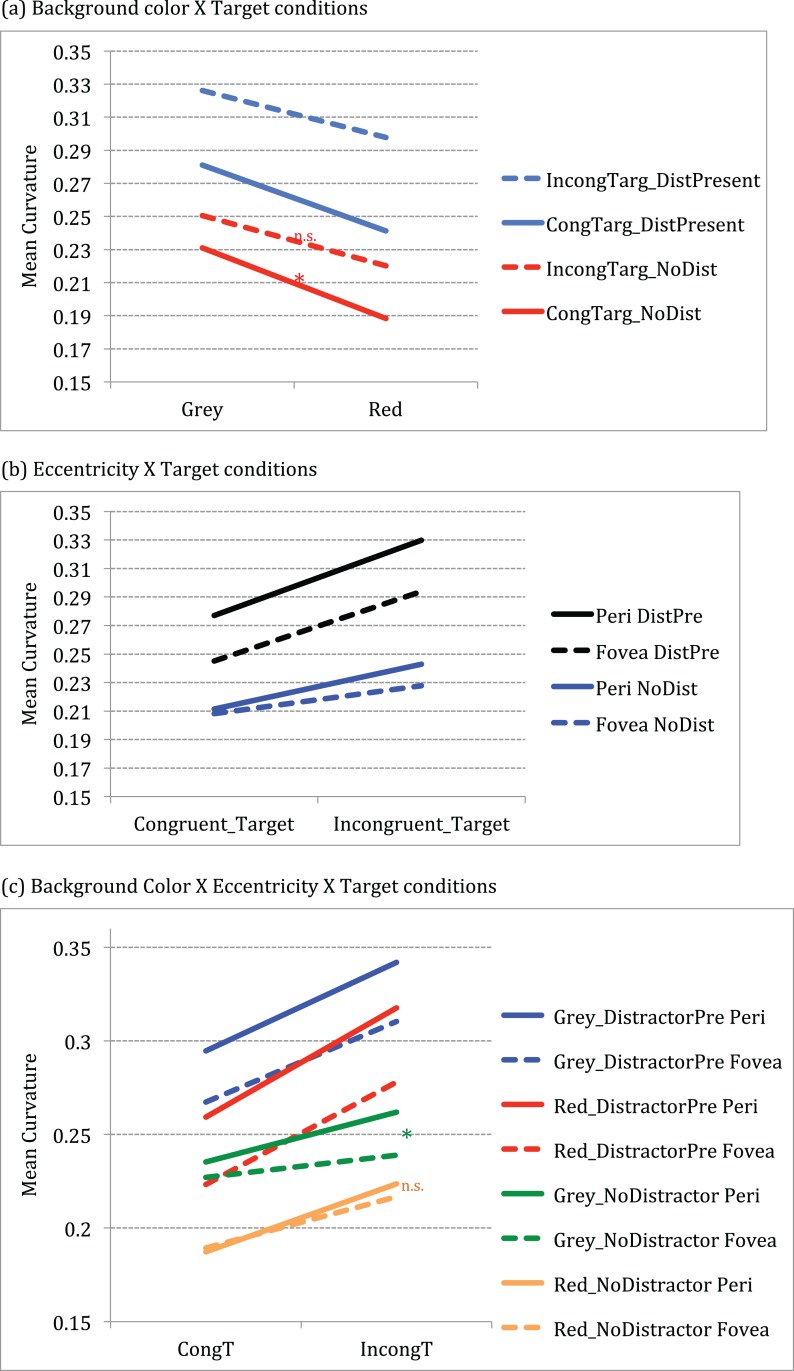
Graphs showing significant interactions between conditions.(A) Significant 2-way interaction between Background color × Target conditions (B) Significant 2-way interaction between Eccentricity × Target conditions (C) Significant 3-way interaction between Background color × Eccentricity × Target conditions.